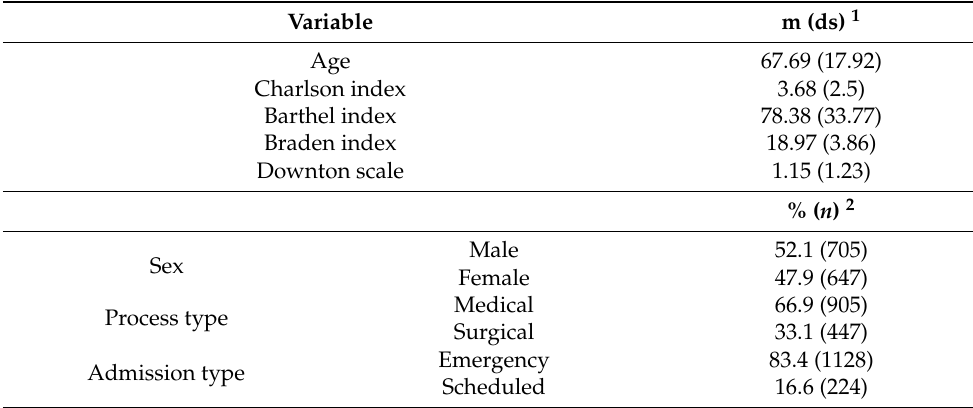
Table 1. Descriptive analysis of the